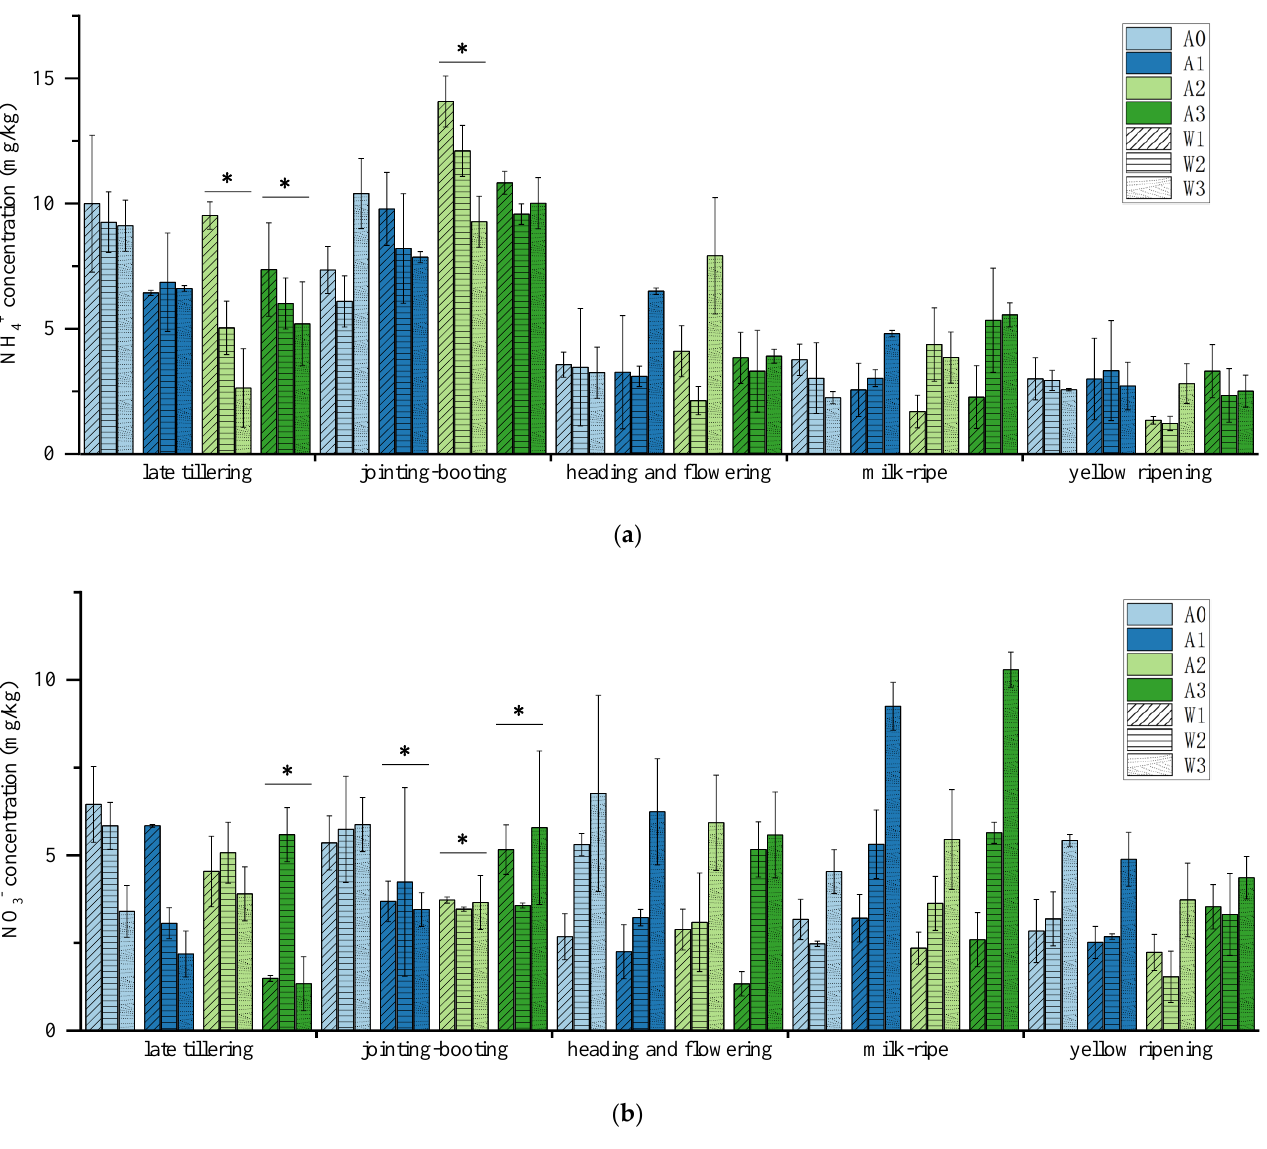
Figure 1. Soil ( a ) NH 4+ and ( b ) NO 3 – concentrations during different growth stages. * indicates a significant difference from the A0 treatment in the same stage. A, the concentration gradient of the antibiotic sulfamethazine, including A0 (0 ng·L −1 ), A1 (500 ng·L −1 ), A2 (1500 ng·L −1 ), and A3 (3000 ng·L −1 ). W, irrigation methods, including W1 (flood irrigation), W2 (mild AWD), and W3 (severe AWD).